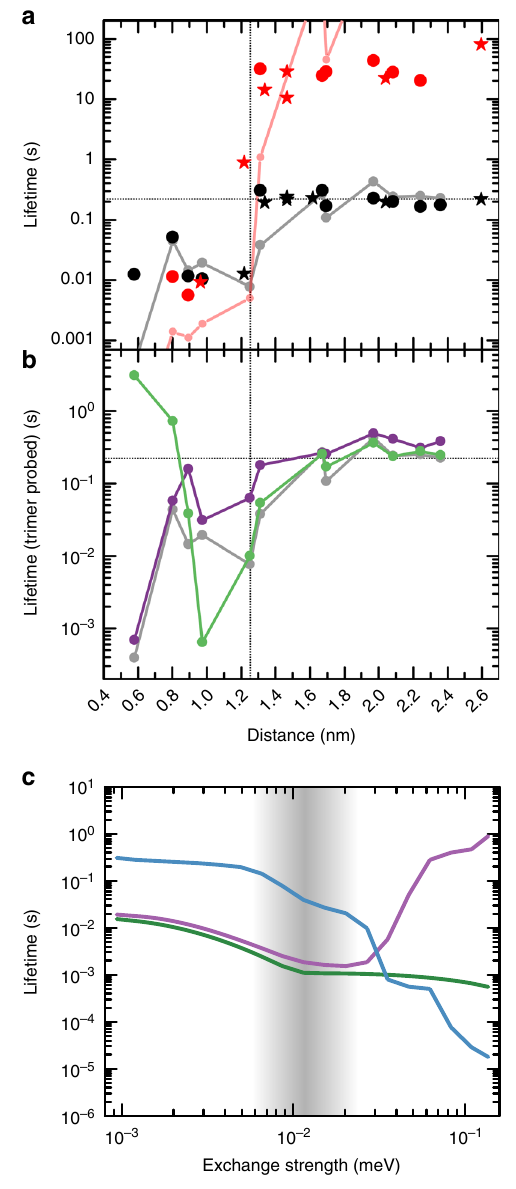
Fig. 3 Distance dependence of the spin lifetime. a Mean lifetimes of the data recorded on the trimer τ (black) and on the atom τ (red) in dependence of t a the trimer − atom separation (Note, that the lifetimes for the separation corresponding to the con fi guration in Fig. 1a differ from those in Fig. 1b due to a different measurement voltage, V = − 5mV, I = 500 pA, B = 0 T and T = 300mK). Data points of the complexes with an fcc (hcp) adsorbed satellite atom are marked with a circle (star). The horizontal (vertical) dashed line marks the lifetime of the free-standing trimer (the crossover between the two lifetime regimes). In gray (weak red) the simulated lifetimes for the scenario of the tip probing the trimer (the satellite atom) are given. b Calculated lifetimes probed on the trimer for the experimental separations using different parts of the exchange interactions. The reference data using the full exchange interactions are shown in gray. The lifetimes calculated without the symmetric anisotropic exchange are shown in green. The lifetimes calculated without the DM interaction are shown in purple. c Calculated lifetimes probed on the trimer in dependence of the isotropic exchange interaction J iso (AFM: green, FM: purple) and the DM interaction D x (blue). For the calculations, the two remaining exchange contributions are set to zero (Supplementary Note 7). The gray area marks the regime of the exchange constants found for an atom − trimer separation of about